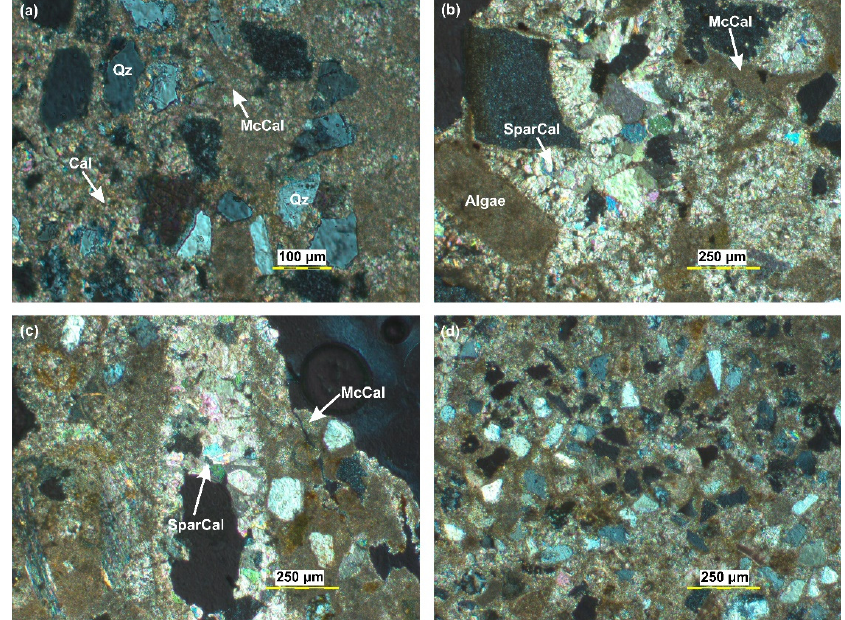
Figure 10. Representative photomicrographs under crossed polars illustrating caprock composition of marine terrace V. The photomicrographs are taken from polished thin sections of caprock sample KESK SaprCal: Sparitic Calcite cement, McCal: Micritic Calcite, Cal: Calcite, Qz: quartz. Well-devel- oped sparitic and micritic calcite crystals with light brown color are indicative of cement. ( a ), Mi- critic calcite consolidates lithoclasts and minerals, ( b , c ) well developed sparitic calcite crystals are observed, ( d ) general look of sample KESK bioclasts, lithoclasts and minerals, ( c ), Close look of the bonding between bioclasts and algae by spartic calcite, ( d ) high contribution of bioclast. 4.3. Optically Stimulated Luminescence (OSL) Dating—Uplift Rates The OSL dating of the caprock sample (K5_SKL) collected from VI terrace near Skala village gave an age of 59.1 ± 0.3 ka (Table 1). Table 1. Results and details of OSL dating. Equivalent dose values were determined using the cen- tral age model (CAM) of Galbraith et al. [30]. Water content expressed as a percentage of the mass of dry sediment, calculated using field values. Beta, gamma, and cosmic dose rates were combined to calculate the total dose rates after Aitken [60]. Beta and gamma dose rates were calculated using the conversion factors of Liritzis et al. [61]. Beta dose rates have been corrected for the effect of the water content, grain size, and chemical etching. Gamma dose rates have been corrected for the effect of the water content. Cosmic dose rates were calculated according to [62,63]. Age, before 2016 AD. Sample Sample ID Lab. Reference